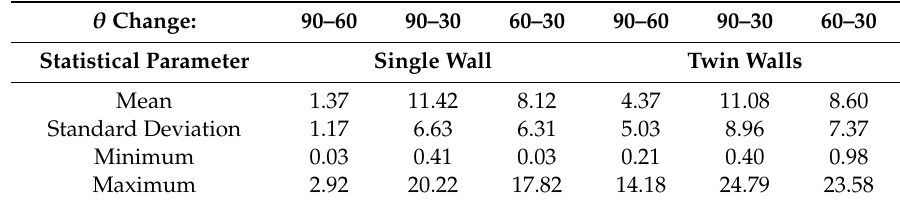
Table 5. Simple statistics of the percentage of decrease in K t as a function of wall slope angle and number of walls.